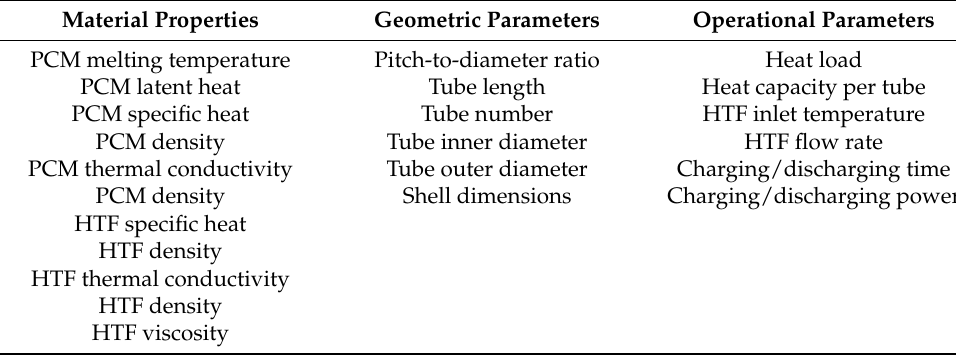
Table 4. Variables for the